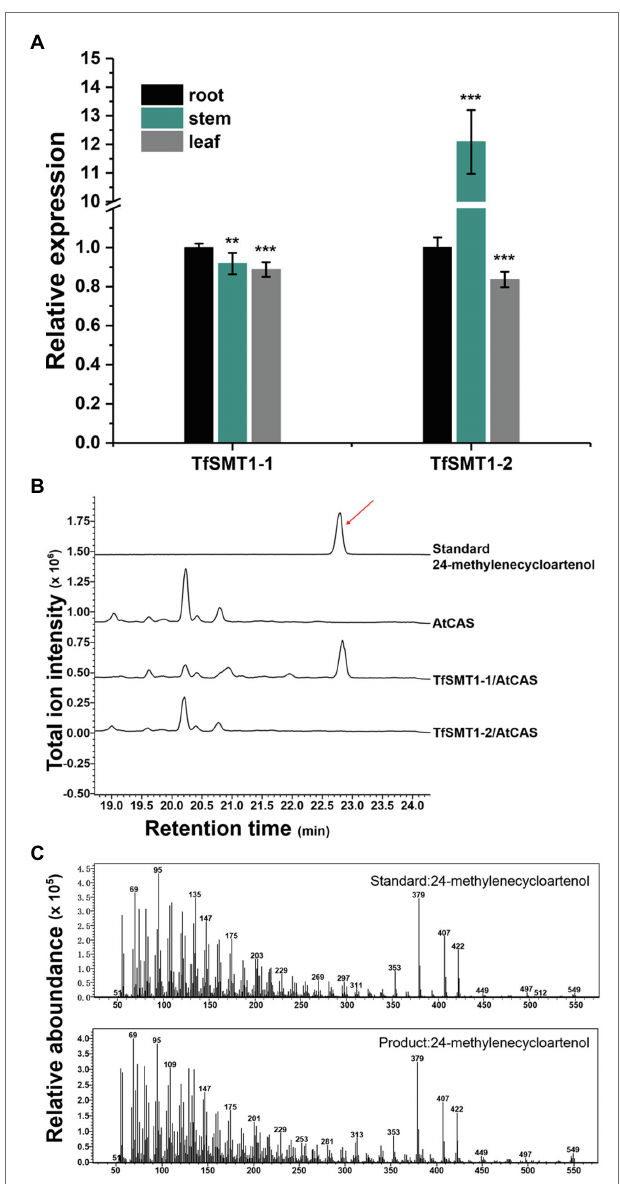
FIGURE 3 | Gene expression patterns in different tissues and biochemical functions of TfSMT1-1 and TsSMT1-2. (A) , relative transcript abundances of TfSMT1-1 and TfSMT1-2 gene in different tissues (root, shoot, and leaf) analyzed by real-time PCR. The gene expression level in the root organ was considered as a value of 100% and that in other tissues was accordingly normalized ( n = 3 biological replicates, **p < 0.05 and ***p < 0.01 by one-way ANOVA). (B) , in vivo functional assays of TfSMT1-1 and TfSMT1-2 co- expressed with the Arabidopsis thaliana cycloartenol synthase (AtCAS) in yeast. GC profile was shown for the products from the yeast cell expressing TfSMT1-1/AtCAS, TfSMT1-2/AtCAS, and AtCAS alone. (C) , the mass spectra of 24-methylenecycloartanol standard and the 24-methylenecycloartanol product formed by